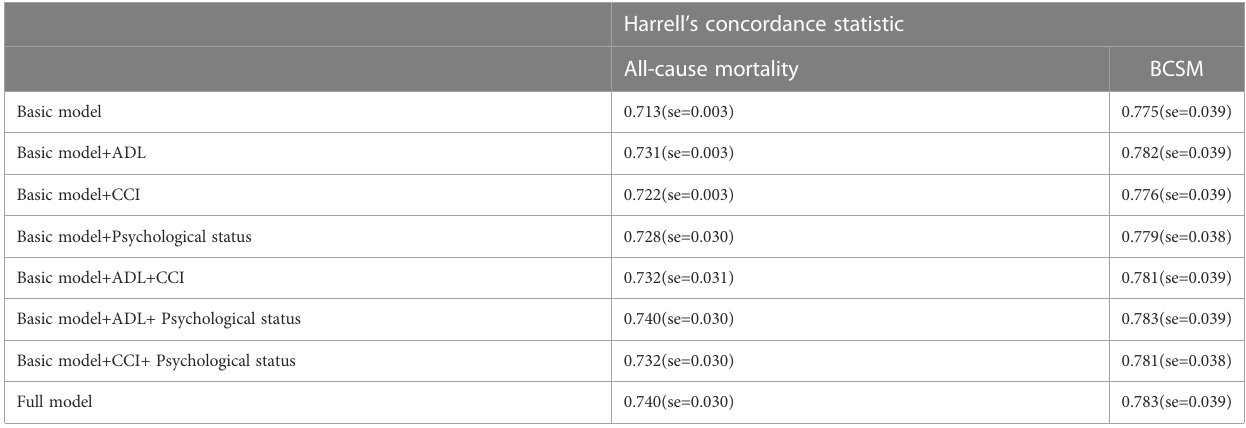
TABLE 4 Comparison of model performance for all-cause mortality and